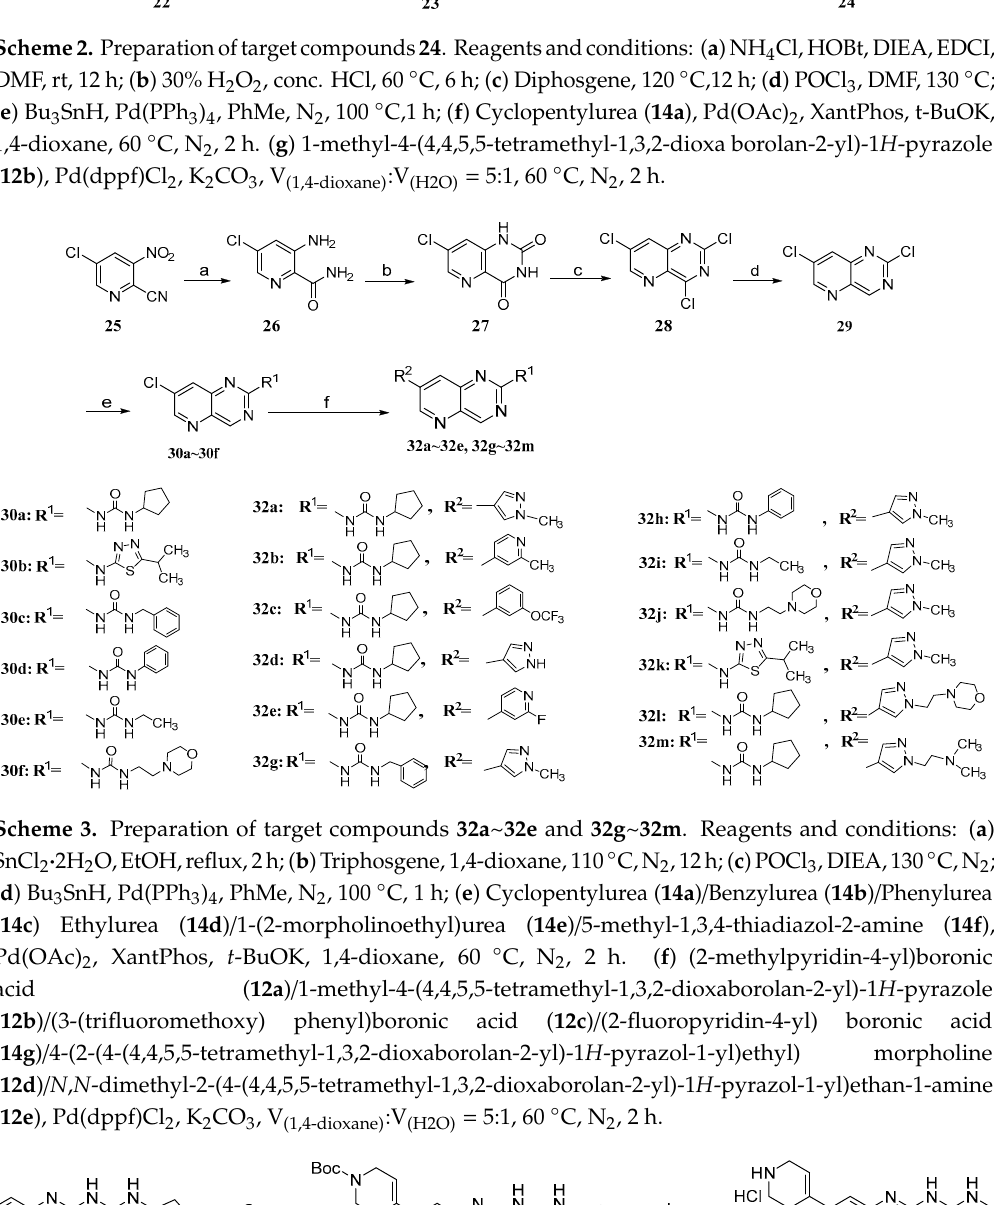
Scheme 2. Preparation of target compounds 24 . Reagents and conditions: ( a ) NH 4 Cl, HOBt, DIEA, Scheme2. Preparationoftargetcompounds 24 . Reagentsandconditions: ( a )NH 4 Cl, HOBt, DIEA,EDCI,